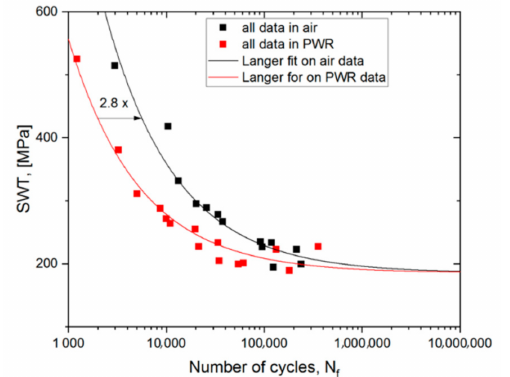
Figure 10. Langer fits on the SWT